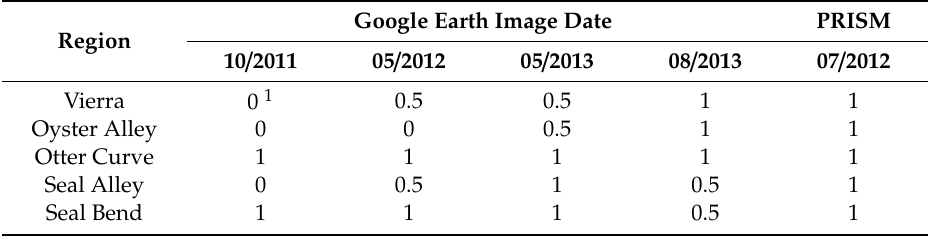
Table 1. Retrieval of di ff erent seagrass beds in Elkhorn Slough from Google Earth time